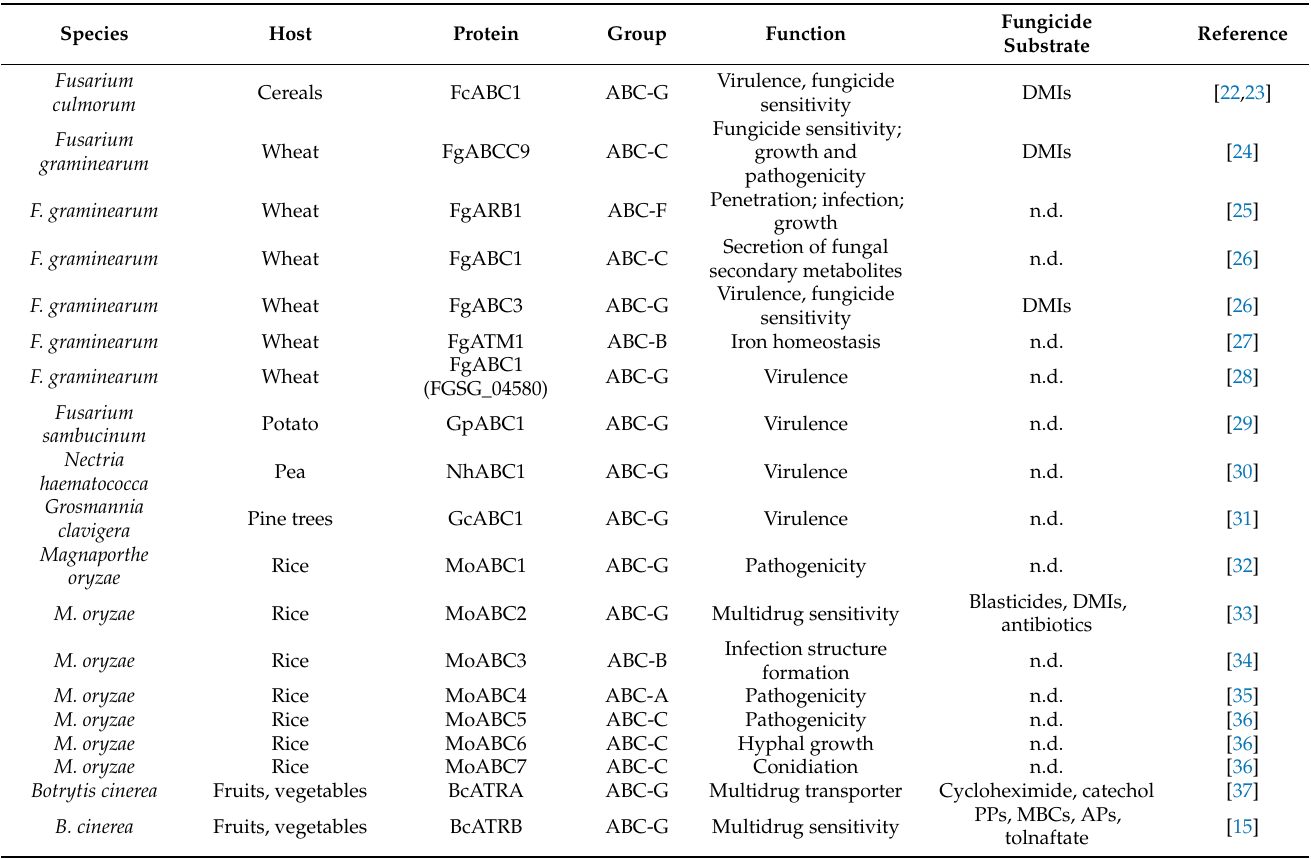
Figure 1. Biological structures of ATP-binding cassette (ABC) and major facilitator superfamily (MFS) transporters. ( A ) Domain arrangements of ABC transporters in the plane of the membrane; ( B ) working model of MFS transporter in the plane of the membrane; ( C ) schematic of “normal” arrangement of transmembrane domain (TMD), nucleotide-binding domain (NBD): Example of the ABC-G and ABC-B families. Table 1. ABC and MFS transporters identified in plant pathogenic fungi a .